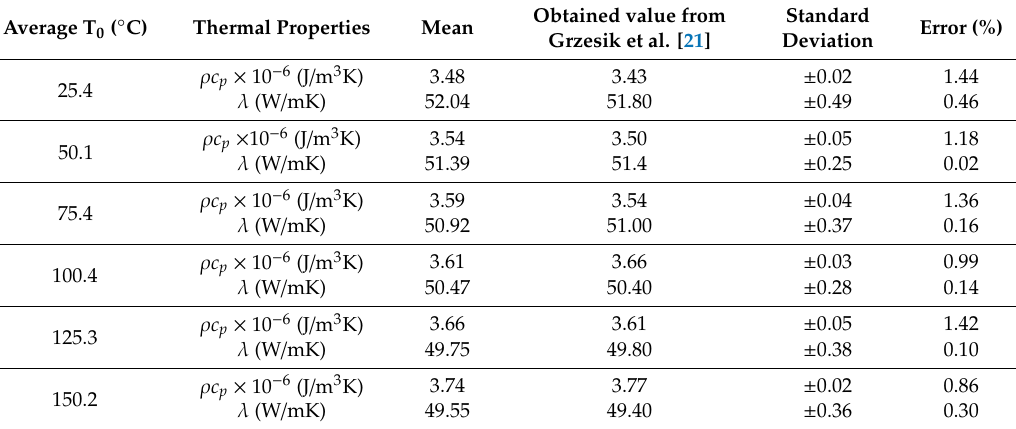
Figure 7. Residuals of temperatures of AISI 1045. The results of ρ c p and λ on the AISI 1045 steel sample for each initial temperature are presented in Table 1. The percentage di ff erence between the average and the literature value was considered to calculate the error. Based on the lower standard deviation and the error found, the estimated values of ρ c λ show a good conformity when compared to the literature values. One can also see that the p and results of ρ c p are more precise due to its higher sensitivity (Figure 3). Table 1. Average results, standard deviation, and error of ρ c p and λ for AISI